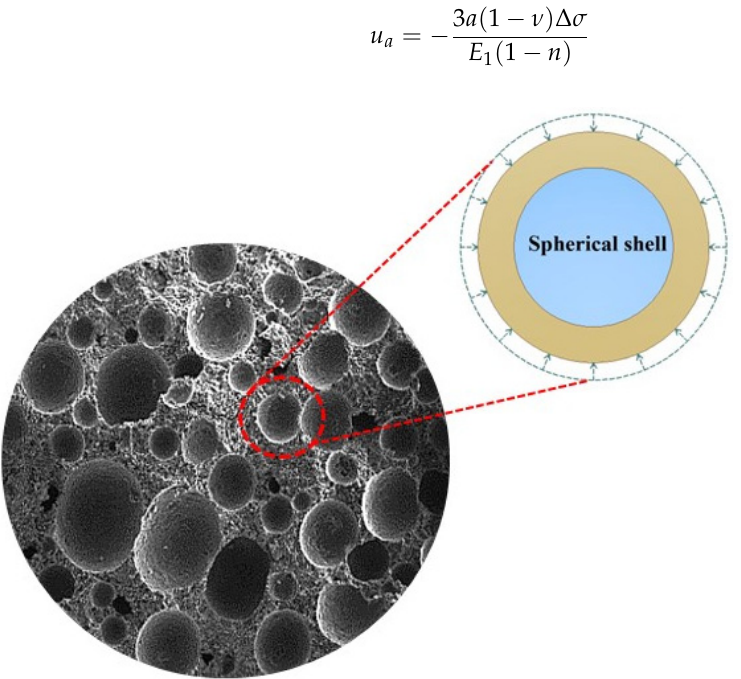
Figure 3. Schematic of the spherical shell of a foamed concrete unit.